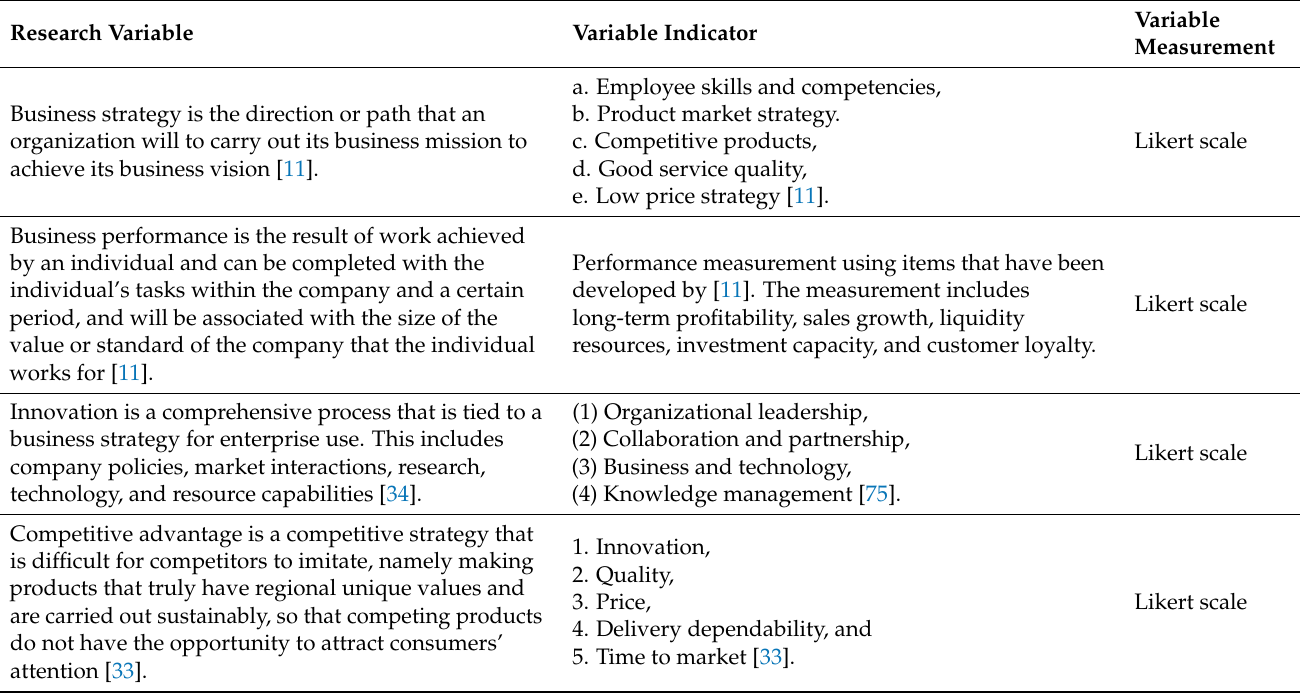
Table 1. Measurement of research variables.